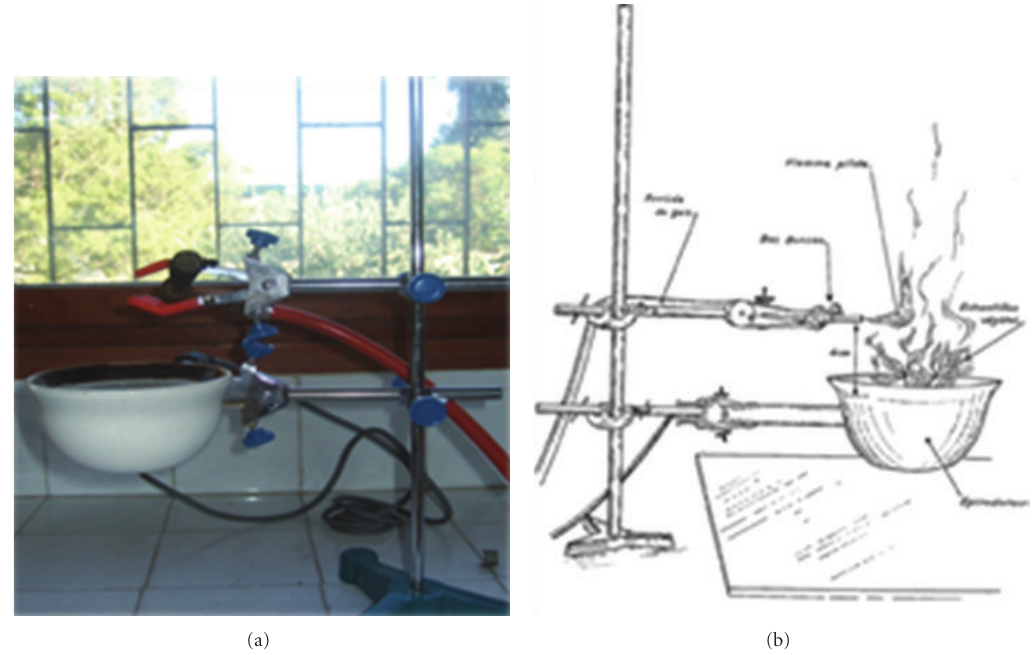
Figure 1: Electric radiator apparatus used for fuel species flammability testing: (a) the real apparatus used in this study and (b) its illustrating schematic